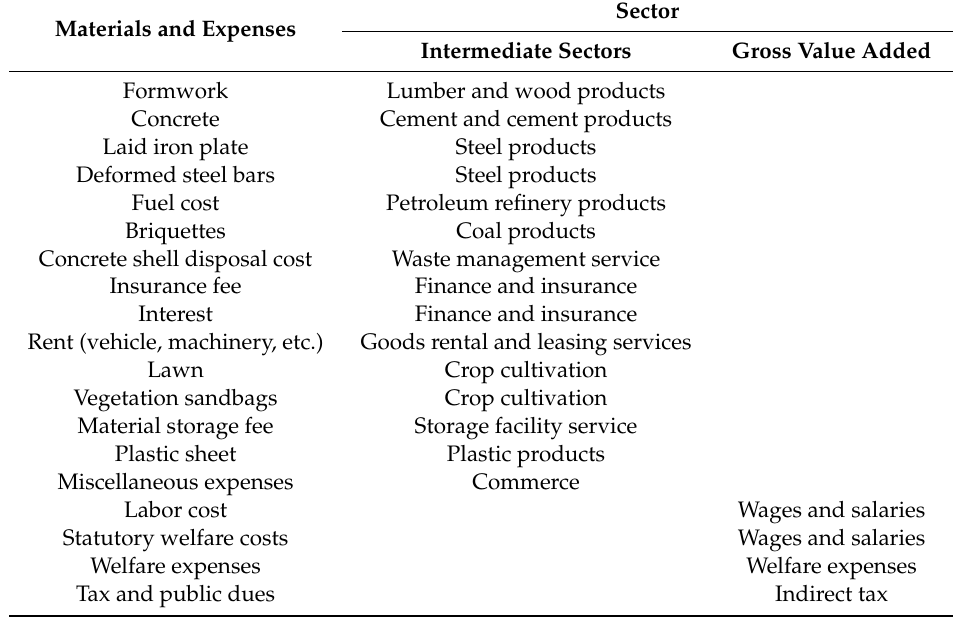
Table 3. Concrete check dam: Assignment of materials and expenses to